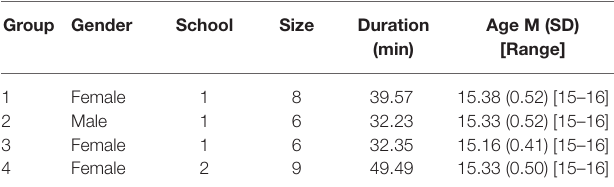
TABLE 1 | Composition and duration of adolescent focus